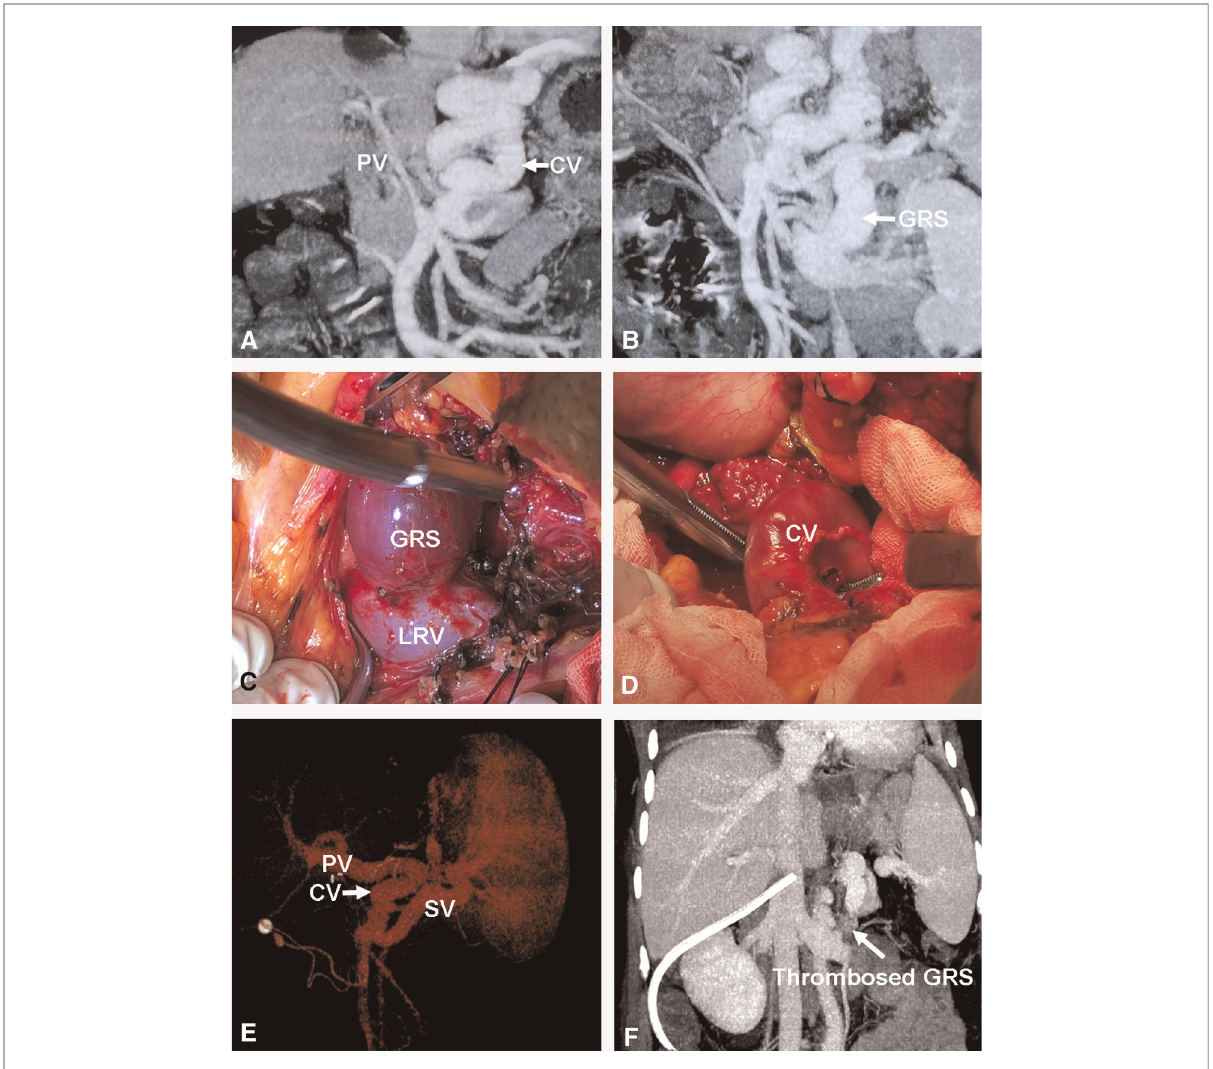
FIGURE 5 Direct ligation of a large GRS and reconstruction of gastric CV with PV. ( A ) Small diameter PV or cavernous transformation of PV. ( B ) Large GRS before transplantation. ( C ) Isolation of large GRS. ( D ) Isolation of gastric CV. ( E ) The images of the PV reconstruction with recipient gastric CV and graft PV on